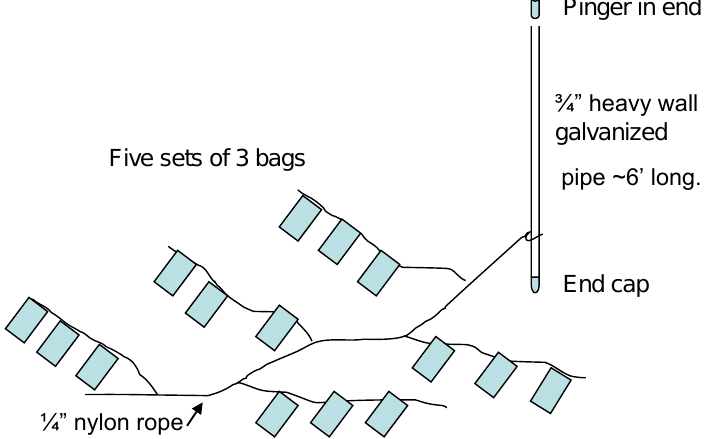
Figure 1. Experimental setup. Bags containing concentrated cysts were deployed at the sea bottom.